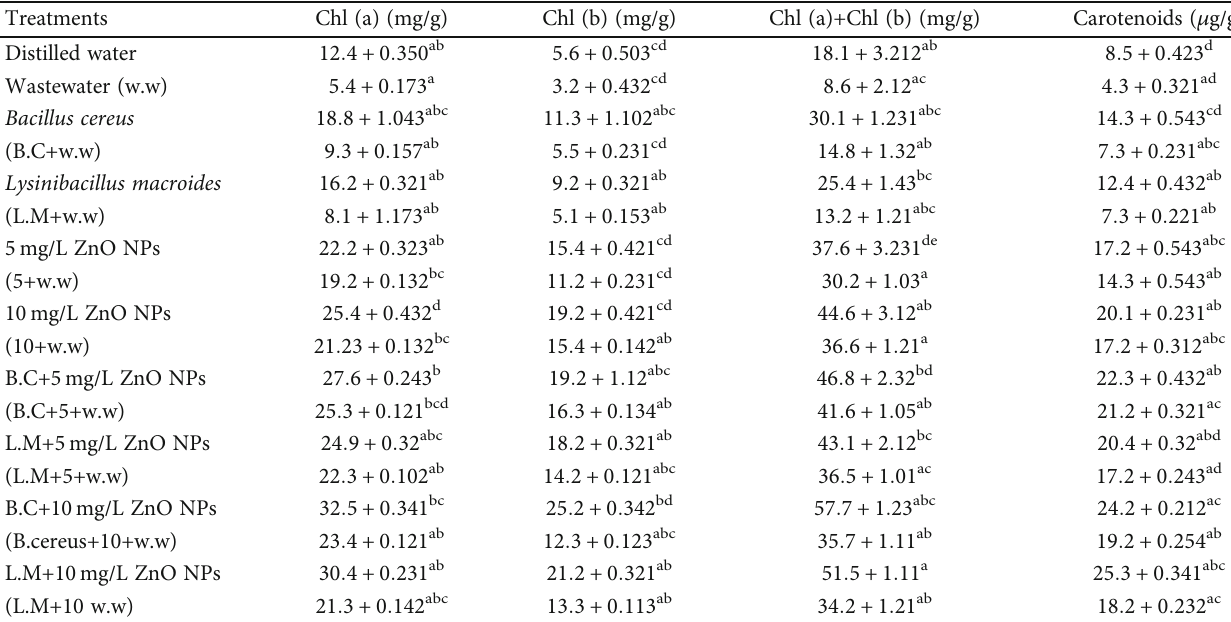
Table 2: Synergistic e ff ect of primed seeds with bacteria strains ( Bacillus cereus and Lysinibacillus macroides ) along with ZnO NP (5 and 10mg/L) treatments on photosynthetic pigments of rice grown in heavy metal-contaminated water. Treatments